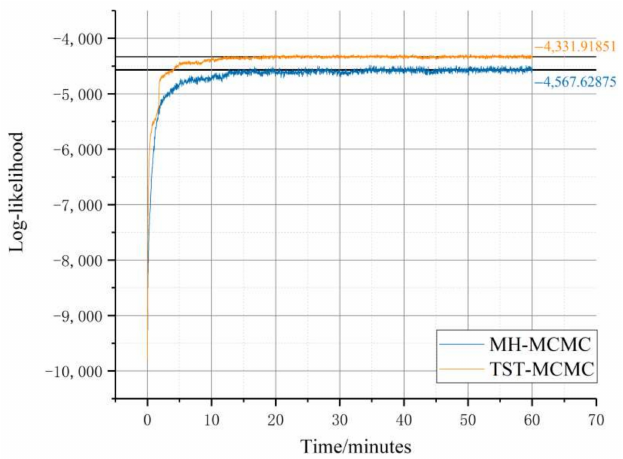
Figure 12. Comparison of two algorithms in metabolic network (the function of the likelihood logarithm with running time; the red one represents TST-MCMC algorithm, while the black one represents MH-MCMC